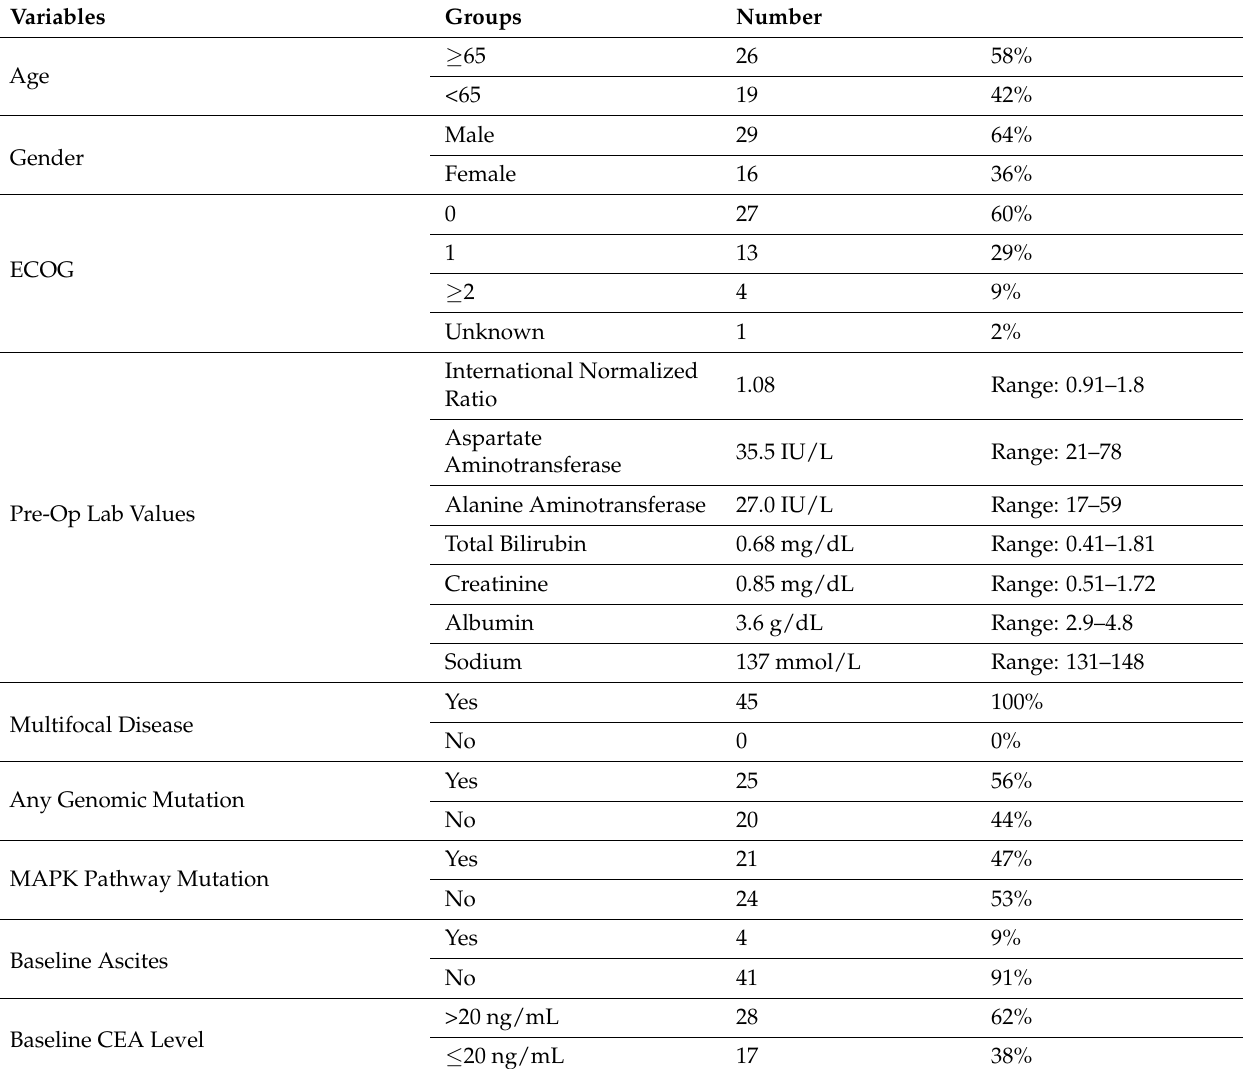
Table 1. Patient Baseline